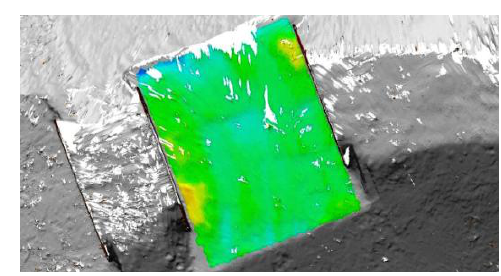
Figure 7. Deviations between UAS-DSM and the adjusted plane of the overflow surface 4 of the polder 2 (view from east)